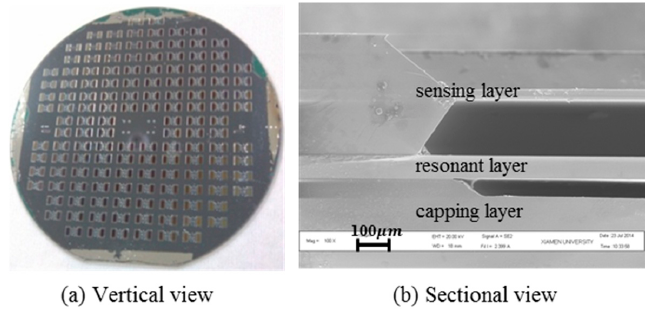
Figure 5. The sensor is after tri-layer anodic bonding by cross-layer. ( a ) The vertical view of the sensor; ( b ) The section view of the sensor.